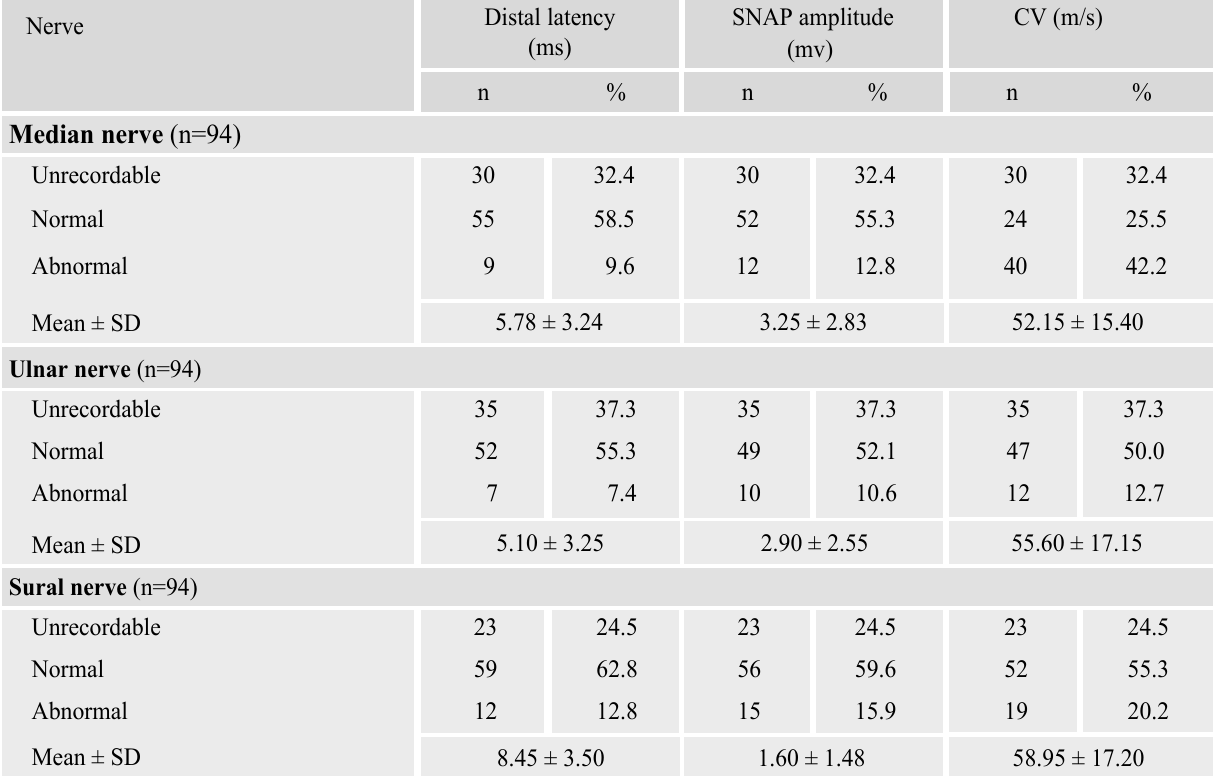
Table II: Results of sensory nerve conduction studies of study population